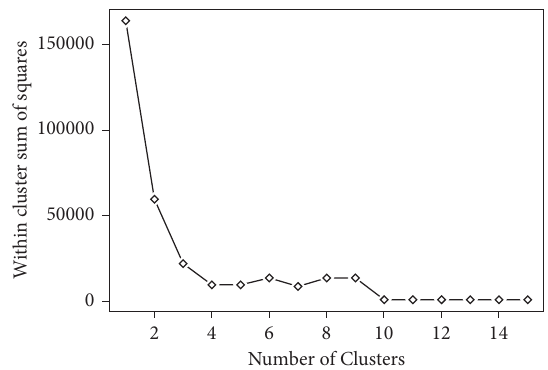
Figure 2: Determination of k using the elbow method.